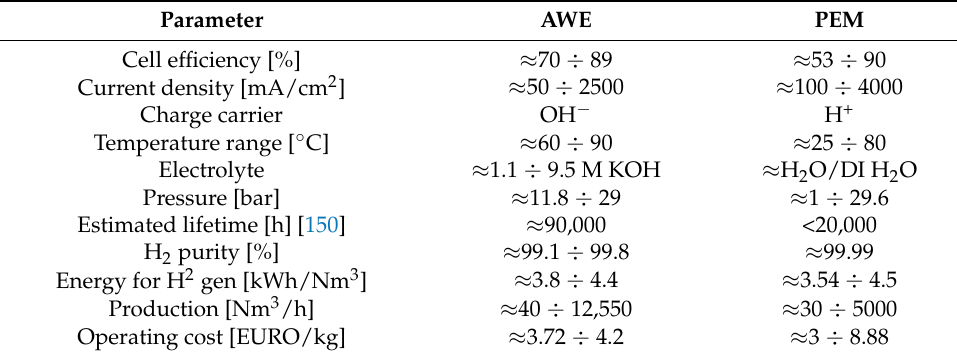
Table 1. Comparison of main electrolysis technologies